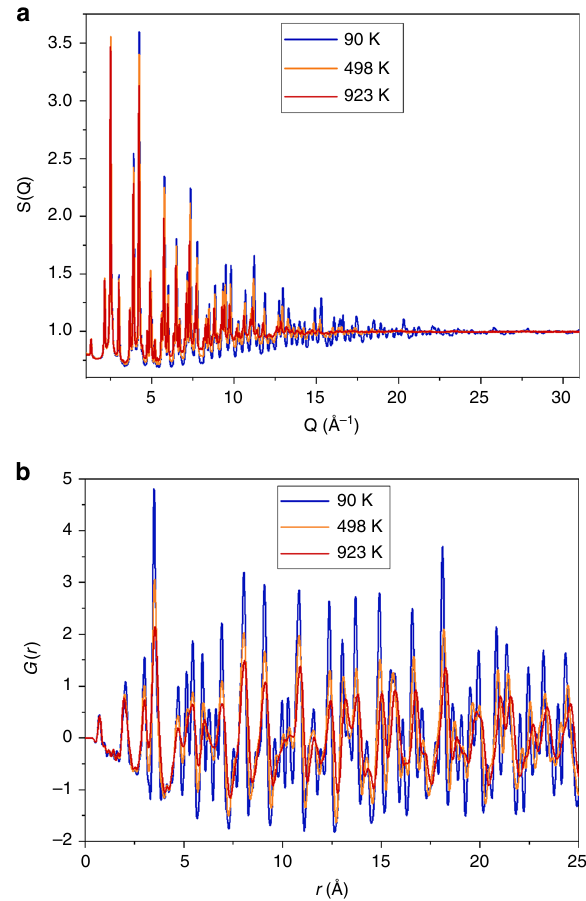
Fig. 1 X-ray scattering data for magnetite. a Scattering intensities S ( Q ) for magnetite at three representative temperatures. b Pair distribution functions G ( r ) derived from S ( Q ) data in a . Typical thermal effects leading to loss of high- Q features in S ( Q ) and broadening of G ( r ) peaks are